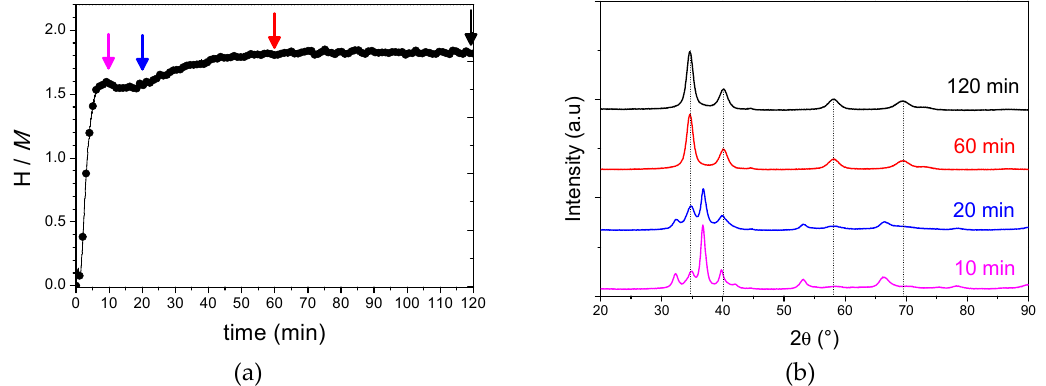
Figure 1. The hydrogen uptake profile during reactive ball milling of Ti 0.325 V 0.275 Zr 0.125 Nb 0.275 under an initial pressure of 70 bar of H 2 ( a ) and the XRD patterns after 10, 20, 60, and 120 min of milling process ( b ) (corresponding to the arrows in the left figure). The peaks originating from the final phase are indicated as dotted lines.